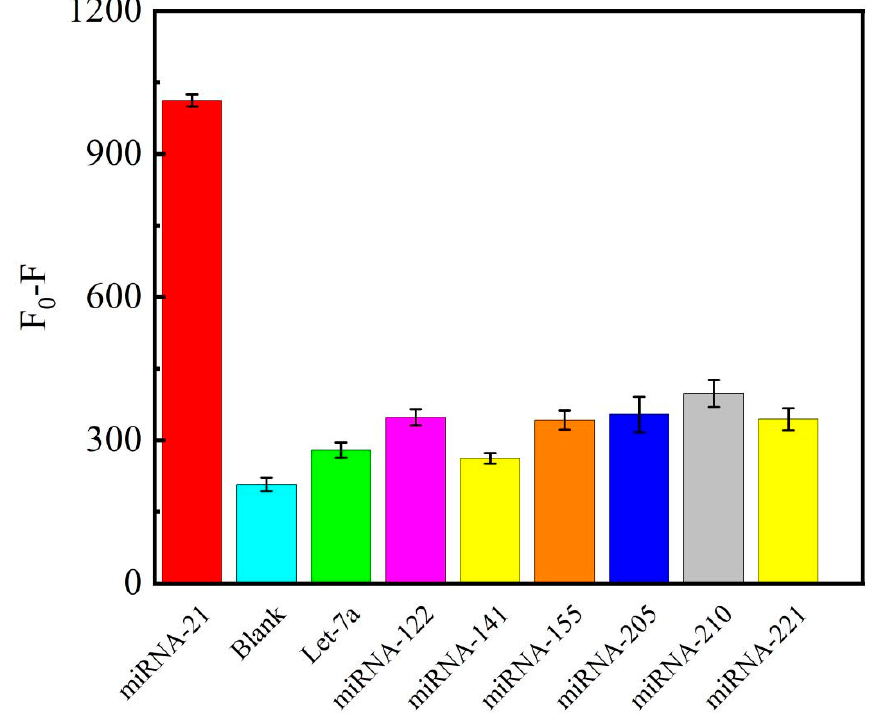
Figure 7. Relative fluorescence intensity at an emission wavelength of 580 nm versus different miRNA species, where the error bars represent the standard deviation of three replicate experi- ments.